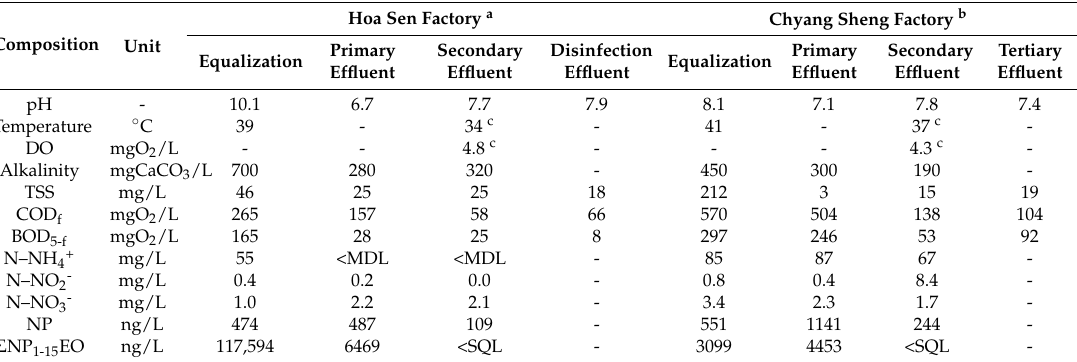
Table 4. Wastewater compositions after each treatment process.